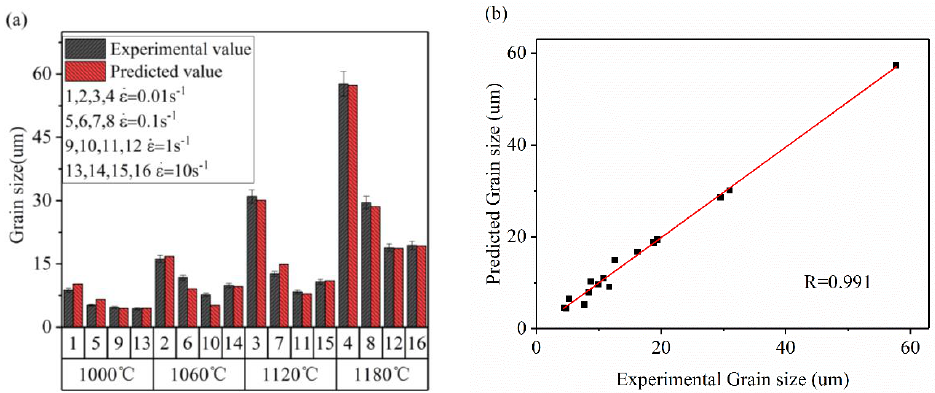
Figure 8. ( a ) DRX grain size prediction results ( b ) and correlation coefficient (R) of the DRX grain size prediction results.